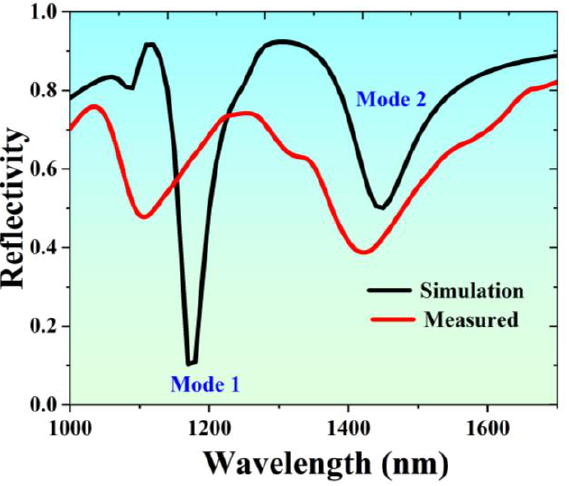
Figure 3. Reflectance spectra of devices tested by simulation and experiment, Figure 3 . Reflectance spectra of devices tested by simulation and experiment, Figure 3 . Reflectance spectra of devices tested by simulation and experiment, respectively. respectively.